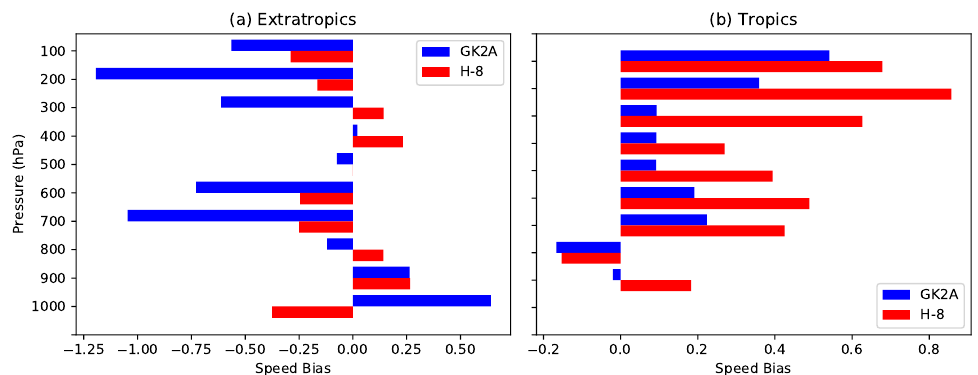
Figure 4. Speed bias of the GK2A (blue) and H-8 (red) AMVs in the extratropics ( a ) and tropics ( b